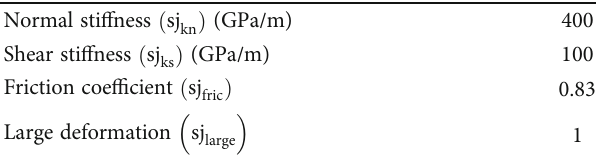
Figure 4: Numerical direct shear test results of fl at joints: (a) shear stress-shear displacement curves; (b) shear strength. Table 2: Microscopic parameters of the SJM.